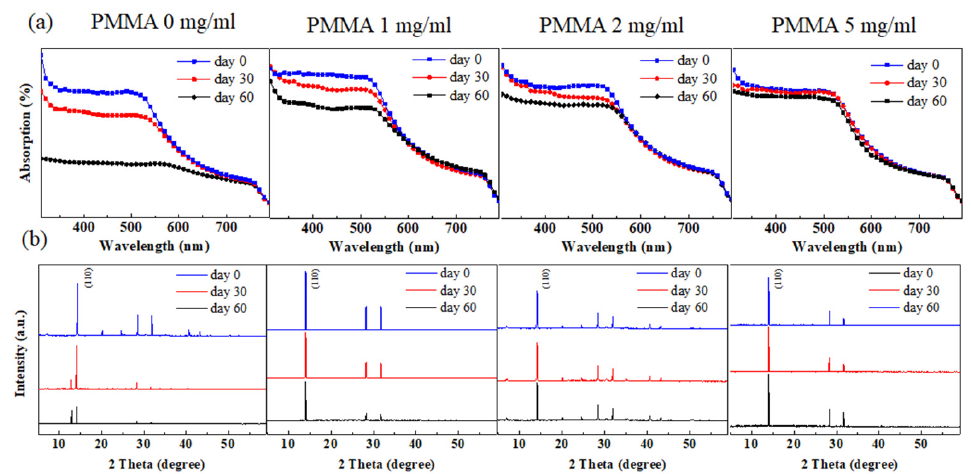
Figure 1. Degradation of perovskite layers with different PMMA (0 mg/mL, 1 mg/mL, 2 mg/mL, and 5 mg/mL): spiro-OMeTAD HTLs. ( a ) Light absorption and ( b ) X-ray diffraction degradation of the perovskite layers over 60 days. The devices were stored in an air environment (RH = 40%), and had a cell structure of ITO/SnO 2 /perovskite/PMMA:spiro-OMeTAD.